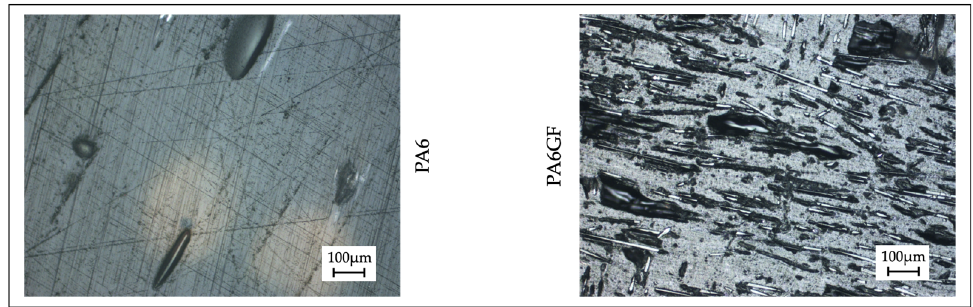
Figure 11. Sections of the printed samples (PA6 on the left side and PA6GF on the right side).